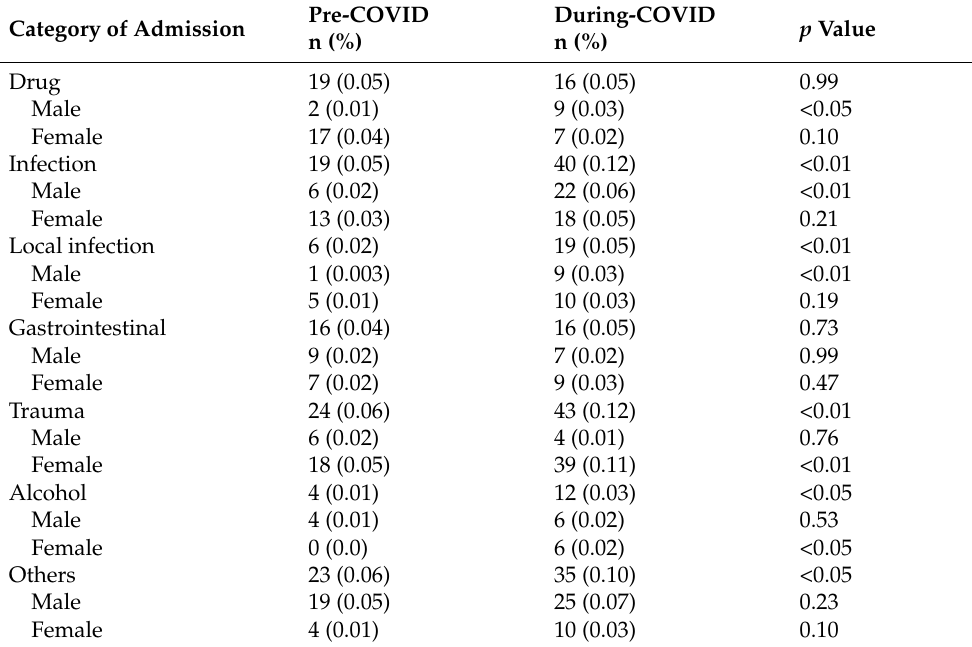
Table 2. ED admission rates for Indigenous Australian patients with SUD before and during the COVID-19 pandemic (the denominator is the total number of